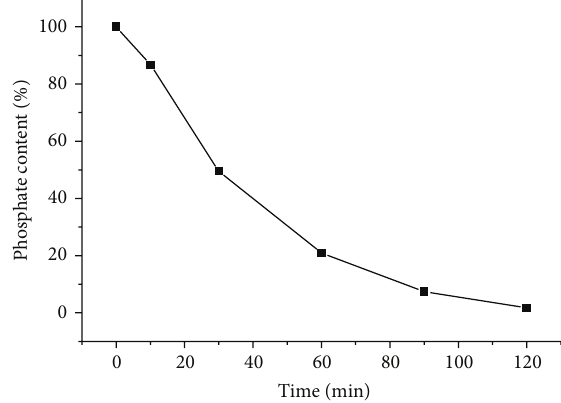
Figure 7: Variation of the concentration of phosphate in the supernatant as a function of